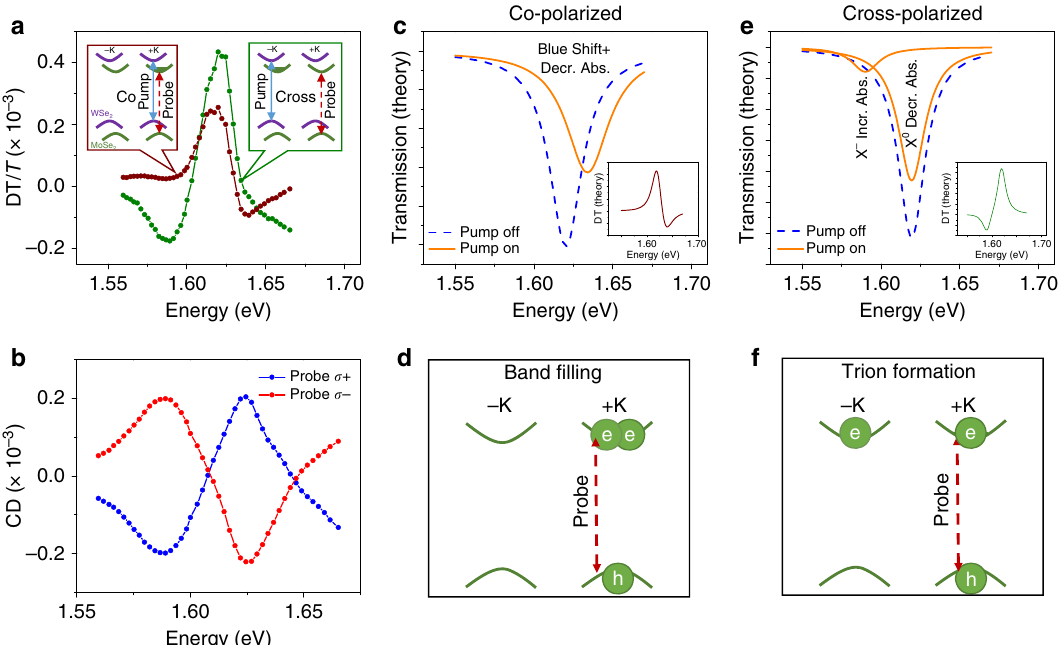
Figure 3 | Interlayer electron spin-valley polarization transfer. ( a ) Co- (burgundy) and cross- (green) circularly polarized DT spectra of the MoSe 2 exciton resonances, when pumping the higher energy WSe 2 exciton resonance at 1.710eV. The insets show the pump and probe scheme, where the pump is the solid blue line, and the probe is the dashed red line. Following the interlayer transfer of photo-excited electrons from WSe 2 to MoSe 2 , spin-valley polarized electrons are pumped into the MoSe 2 layer. The band filling of the MoSe 2 conduction band is shown. ( b ) The pump-induced CD of the MoSe 2 exciton resonances when pumping WSe 2 at 1.710eV flips sign with probe (or pump) helicity. ( c – f ) Theoretical explanations of the DT line shapes. ( c , d ) For co-polarized pump and probe, the polarized electrons populate the same valley that the probe measures. The dominant effect is a band filling effect, so that when the pump is on (orange curve in c ), the resonance is blue shifted and the exciton absorption is partially saturated, relative to the pump off case (blue dashed curve in c ). In this co-polarized configuration, a charged exciton cannot form due to Pauli blocking. ( e , f ) For cross-polarized pump and probe, the polarized electrons populate the opposite valley that the probe measures. The dominant effect is charged exciton (X - ) formation, so that when the pump is on (orange curve in e ), the transmission is decreased at the X - resonance, and increased at the neutral exciton (X o ) resonance, relative to the pump off case (blue dashed curve in e ). The insets of c , e show the difference between the modelled pump on (orange) and pump off (blue dashed) curves, corresponding to the theoretical DT